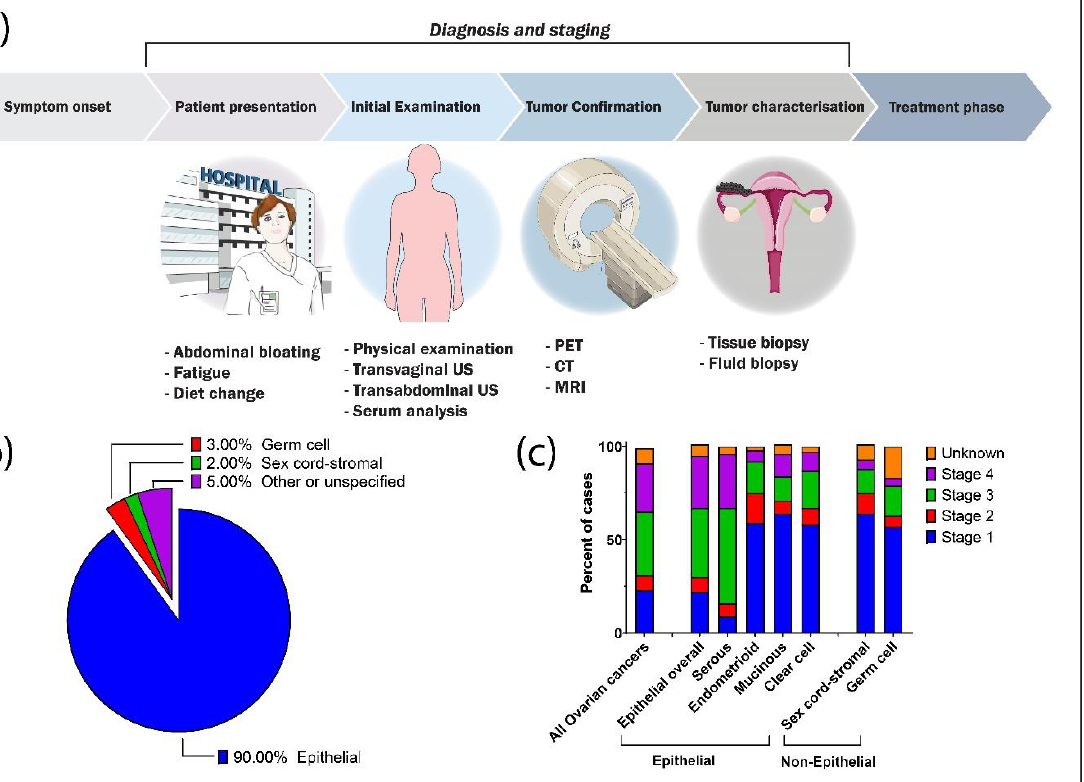
Figure 1. Diagnosis pathway for typical ovarian cancer presentation along with percent occurrence of subtypes and breakdown of diagnosis stage by subtype. ( a ) A schematic flowchart of the diagnostic process from the onset of symptoms to when conventional treatment may begin. After presentation to clinicians, patients may undergo a variety of techniques to confirm and characterise the tumor. In addition, tissue biopsies may be taken simultaneously during cytoreductive surgery, which may then be used for further characterisation. Incidence breakdown by tumor type ( b ) and tumor staging in relation to tumor subtypes ( c ). Data sourced and adapted from Torre et al. [2].